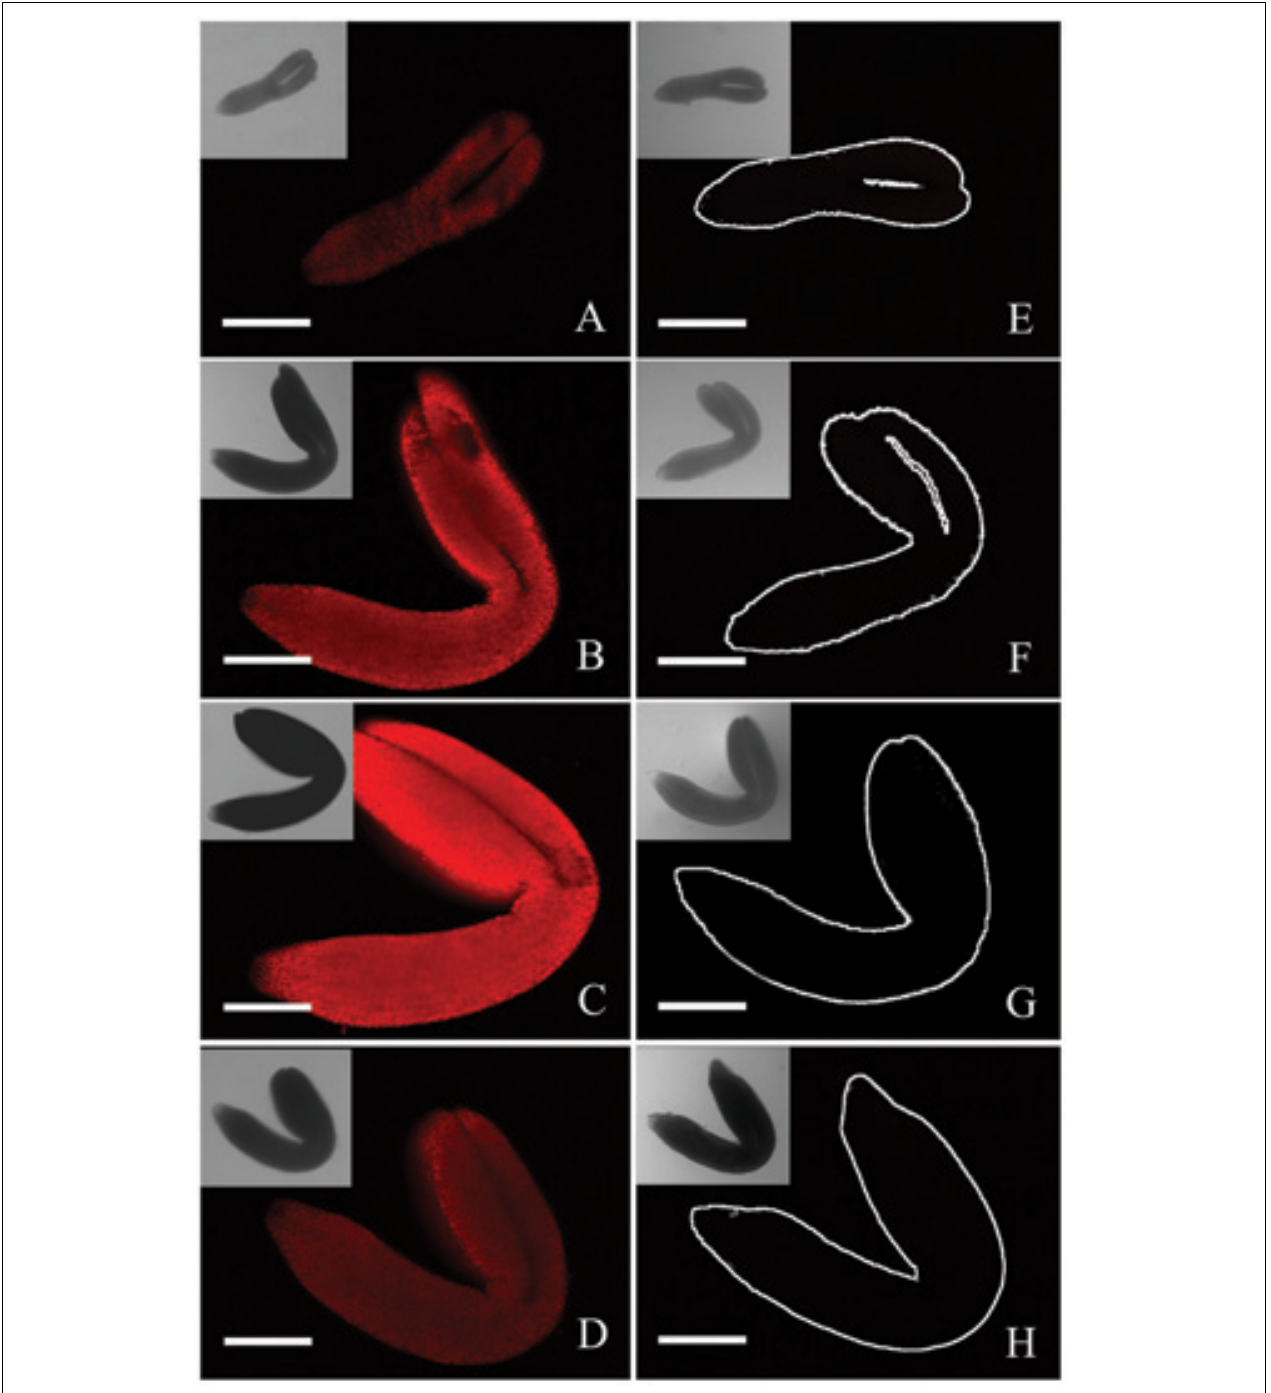
FIGURE 3 | Analysis of chlorophyll fluorescence of control and treated embryos. Both the control (A–D) and treated (E–H) embryos were analyzed with a laser confocal microscope when they were grown for 6 (A,E) , 8 (B,F) , 10 (C,G) , and 12 DAP (D,H) , respectively. Inserts represent corresponding bright field (B,F) images. Bar = 100 µ